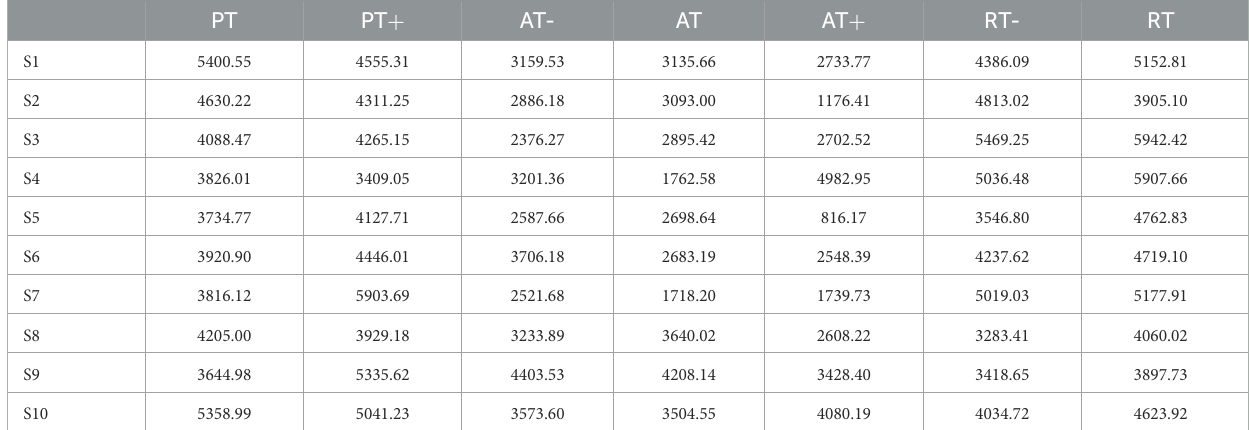
TABLE 3 Total perceived torques values of 10 participants in seven experimental protocols.